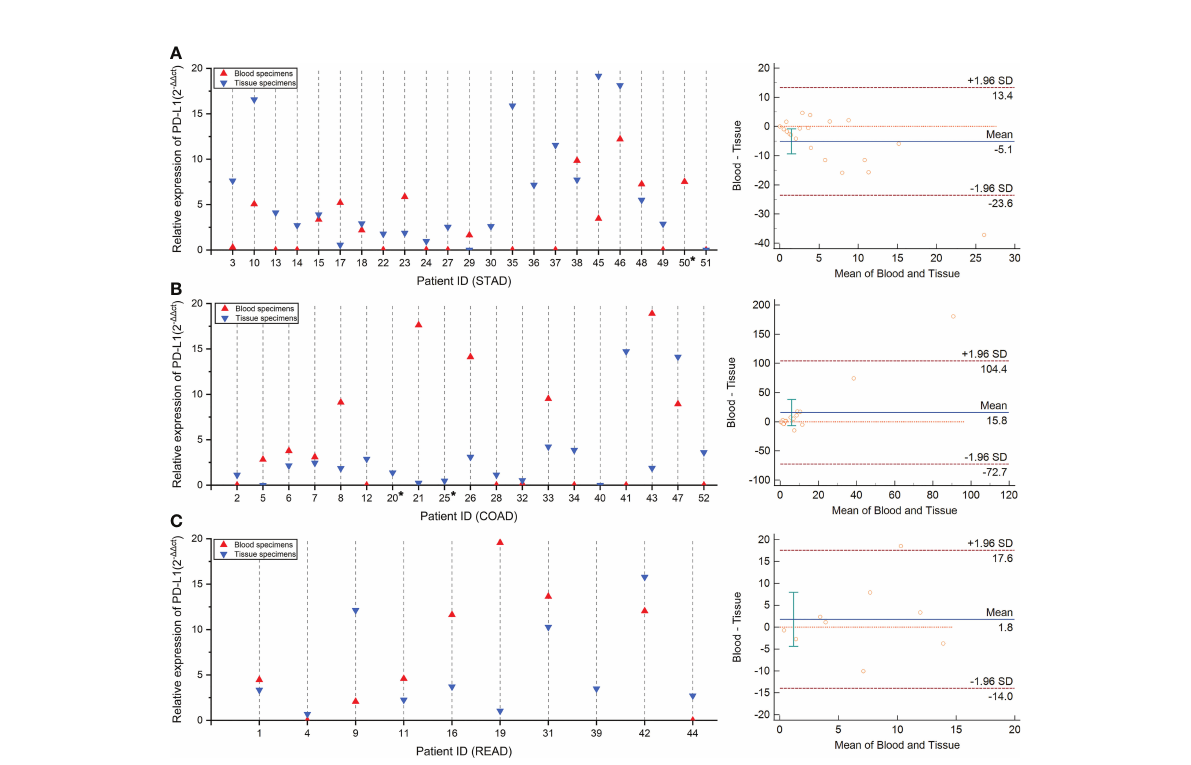
FIGURE 3 The concordance of PD-L1 mRNA expression level between tumor tissue and blood specimens via qRT-PCR test. Panels (A – C) compared the consistency of PD-L1 expression in tissue and blood specimens via qRT-PCR test in patients with stomach, colon, and rectum adenocarcinoma, respectively. The concordance rate and statistical analysis were performed by the Bland – Altman graph, which was drawn on the right